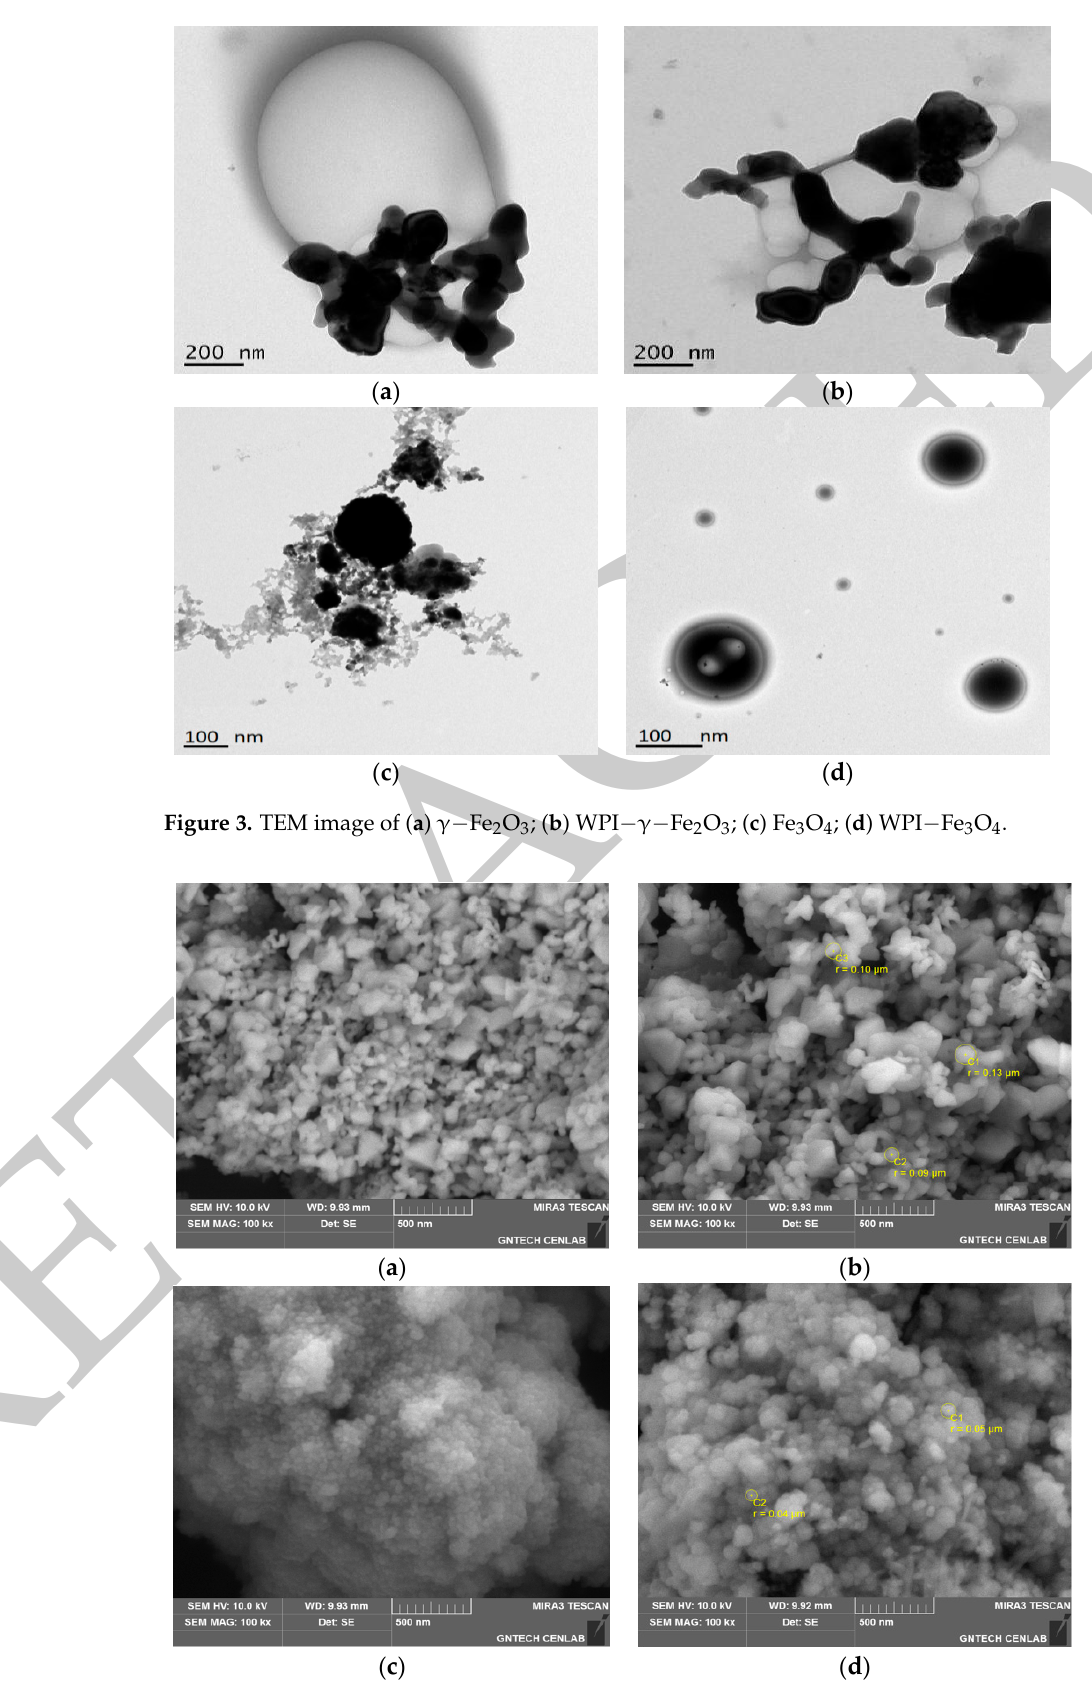
− γ − Fe 2 O 3 ; ( b ) WPI 2 O 3 ; ( c ) Fe 3 O 4 ; ( d ) WPI